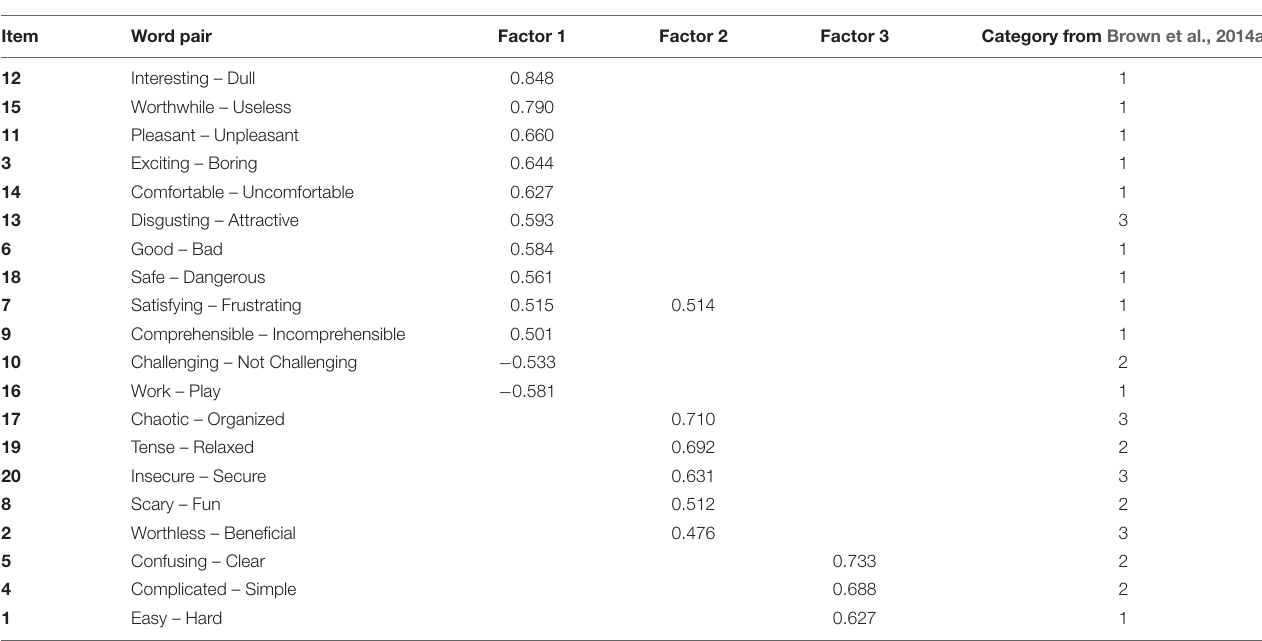
TABLE 1 | Factor loadings for the exploratory factor